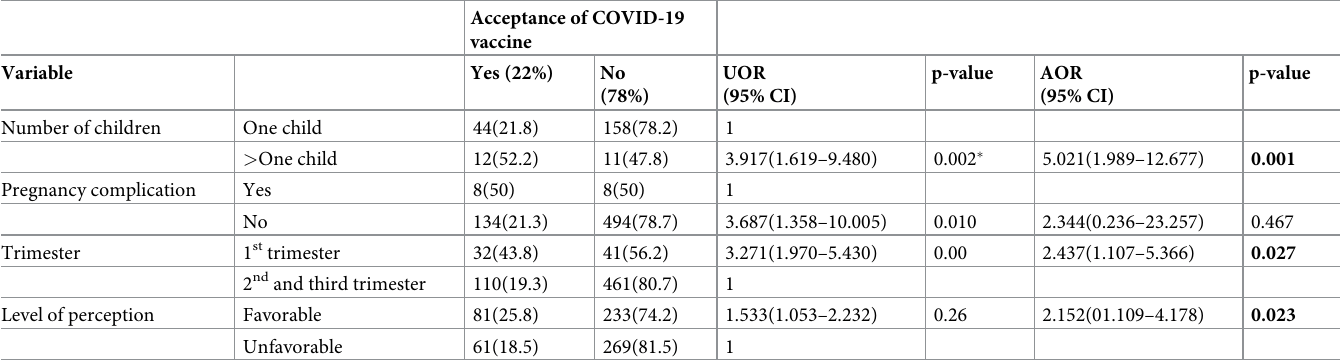
Table 4. Association between acceptance of COVID-19 vaccine and obstetric related factors.